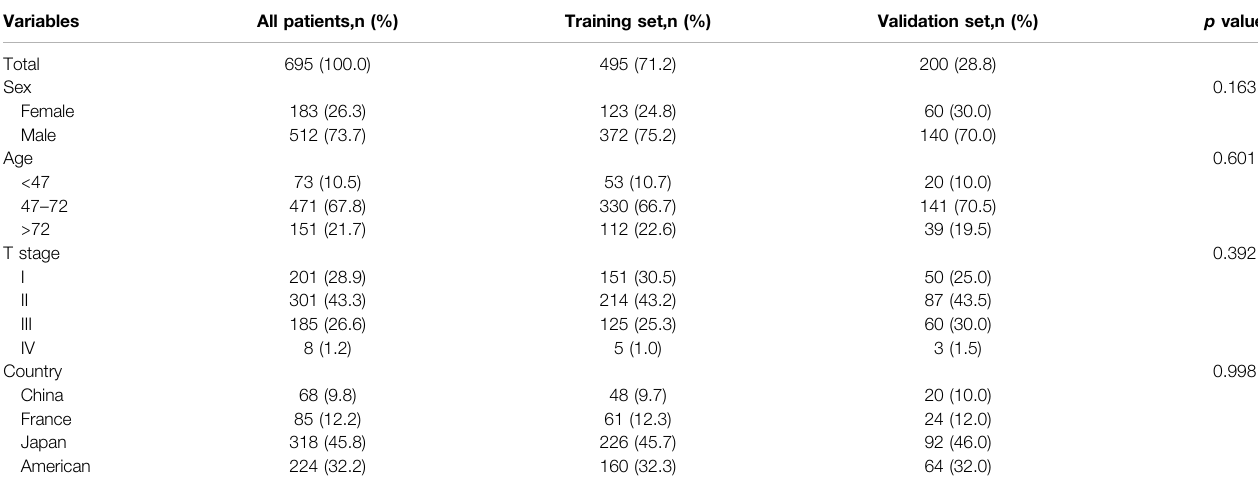
TABLE 1 | Clinical characteristics of all 695 hepatocellular carcinoma patients. Variables All patients,n (%) Training set,n (%) Validation set,n (%) p value Total 695